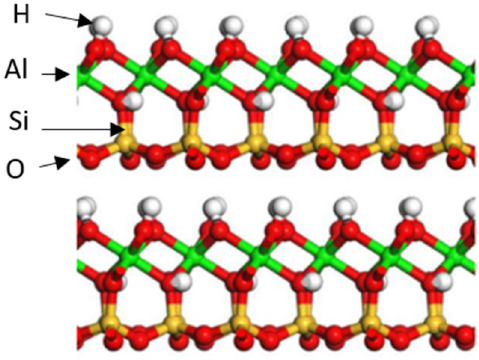
Figure 2. Molecular structure of kaolinite. This image was taken from Dashtian et al. [37].